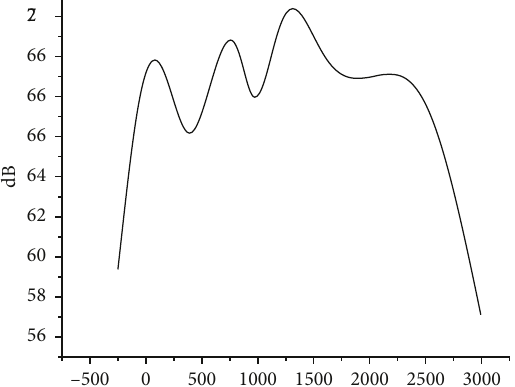
Figure 4: The floor catching curve of an ordinary residential community (furnished room with additional carpet).